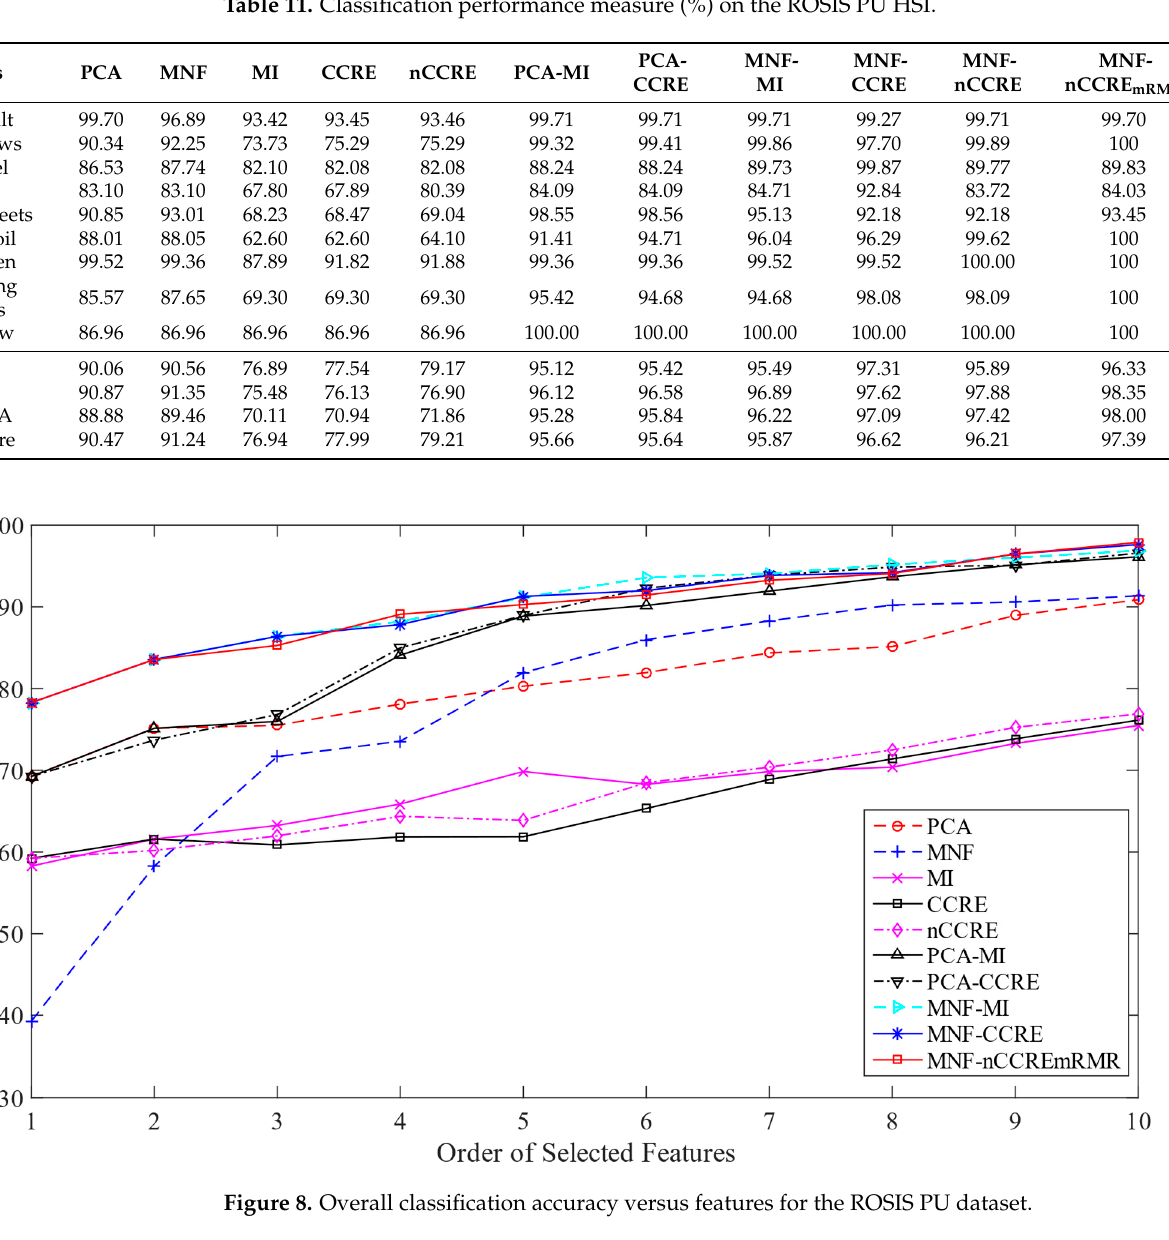
Table 11. Classification performance measure (%) on the ROSIS PU HSI.